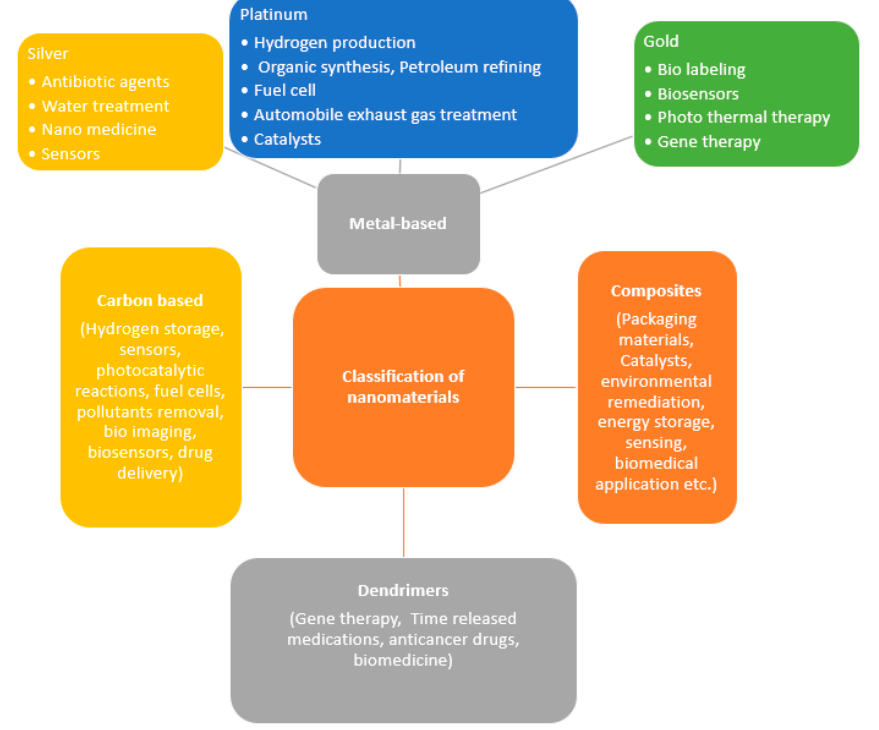
Figure 1. Different classification as well as the extensive range of applications of some of the